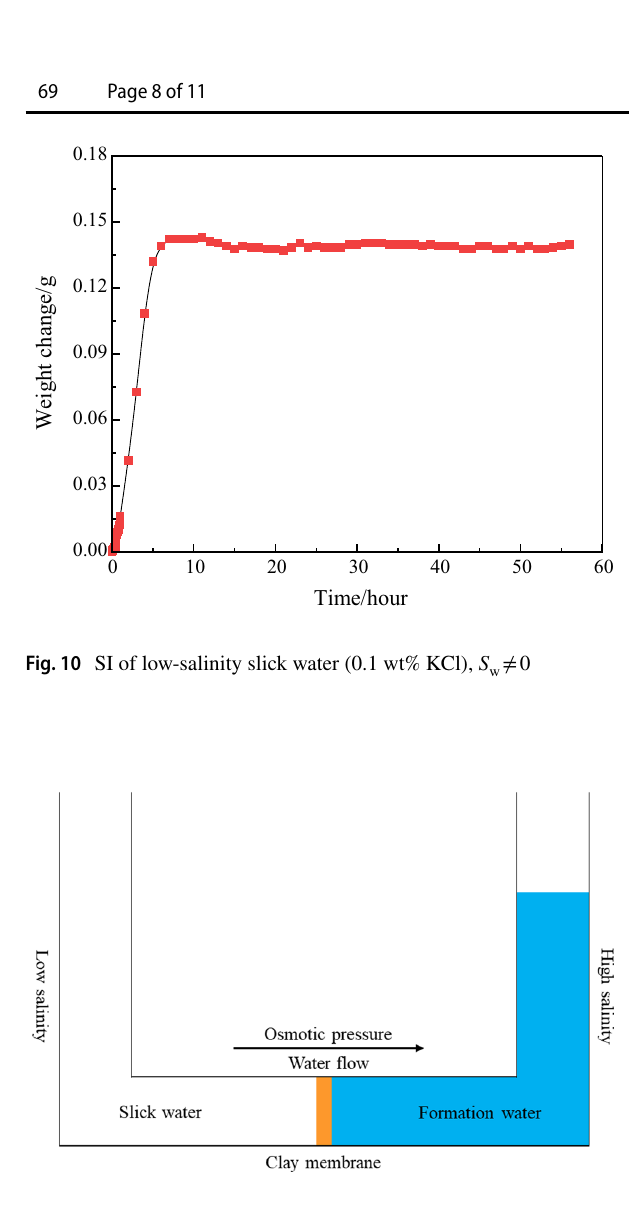
Fig. 11 Schematic diagram of osmotic pressure in low-salinity fluid